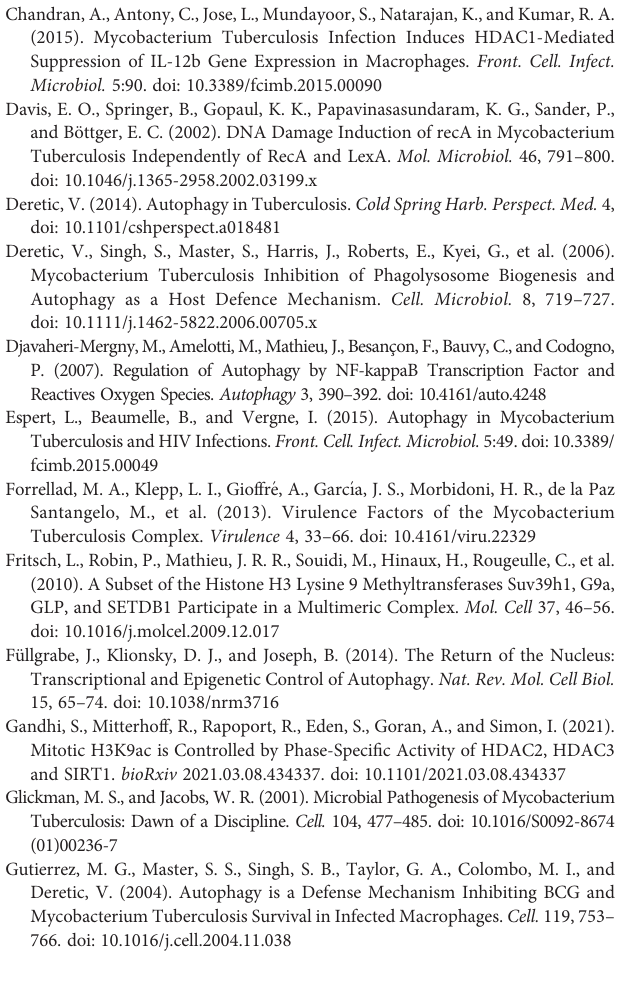
Supplementary Figure 1 | Expression of HDAC1 and HDAC2. RAW264.7 cells were infected with Msm pSMT3 and Mtb Prt for 24 h. The level of HDAC1 and HDAC2 expression at protein level was checked by western blotting.The experiments were performed in triplicate (n=3). Supplementary Figure 2 | Intracellular survival of Mtb PRT after autophagy inhibition by 3MA. RAW 264.7 were infected with Msm pSMT3 and Mtb Prt strains followed by 3MA treatment. Cells were lysed and intracellular bacterial survival was determined 8and24hpost-infection byaCFUassay.Experiments wereperformed in triplicate (n=3). Results are shown as mean ± S.D. ***, p ≤ 0.001; **, p ≤ 0.01; *, p ≤ 0.05.; ns, not signi fi cant. Supplementary Figure 3 | Southern blot analysis of M. tuberculosis prt locus. M. tuberculosis (1, wt) was transformed with prt targeting vector pMCS5-rpsL-hyg- D 3242c, transformants were selected on 7H10 agar containing hygromycin. Putative single cross-over transformant (2, sco) was colony puri fi ed and subjected to streptomycin counter selection to obtain putative D prt deletion mutant (3, D ). Genomic DNA of the indicated strains was isolated, digested with AgeI , separated on an agarose gel, blotted and probed with a 128bp probe located upstream of the target gene. The band patterns con fi rm the predicted